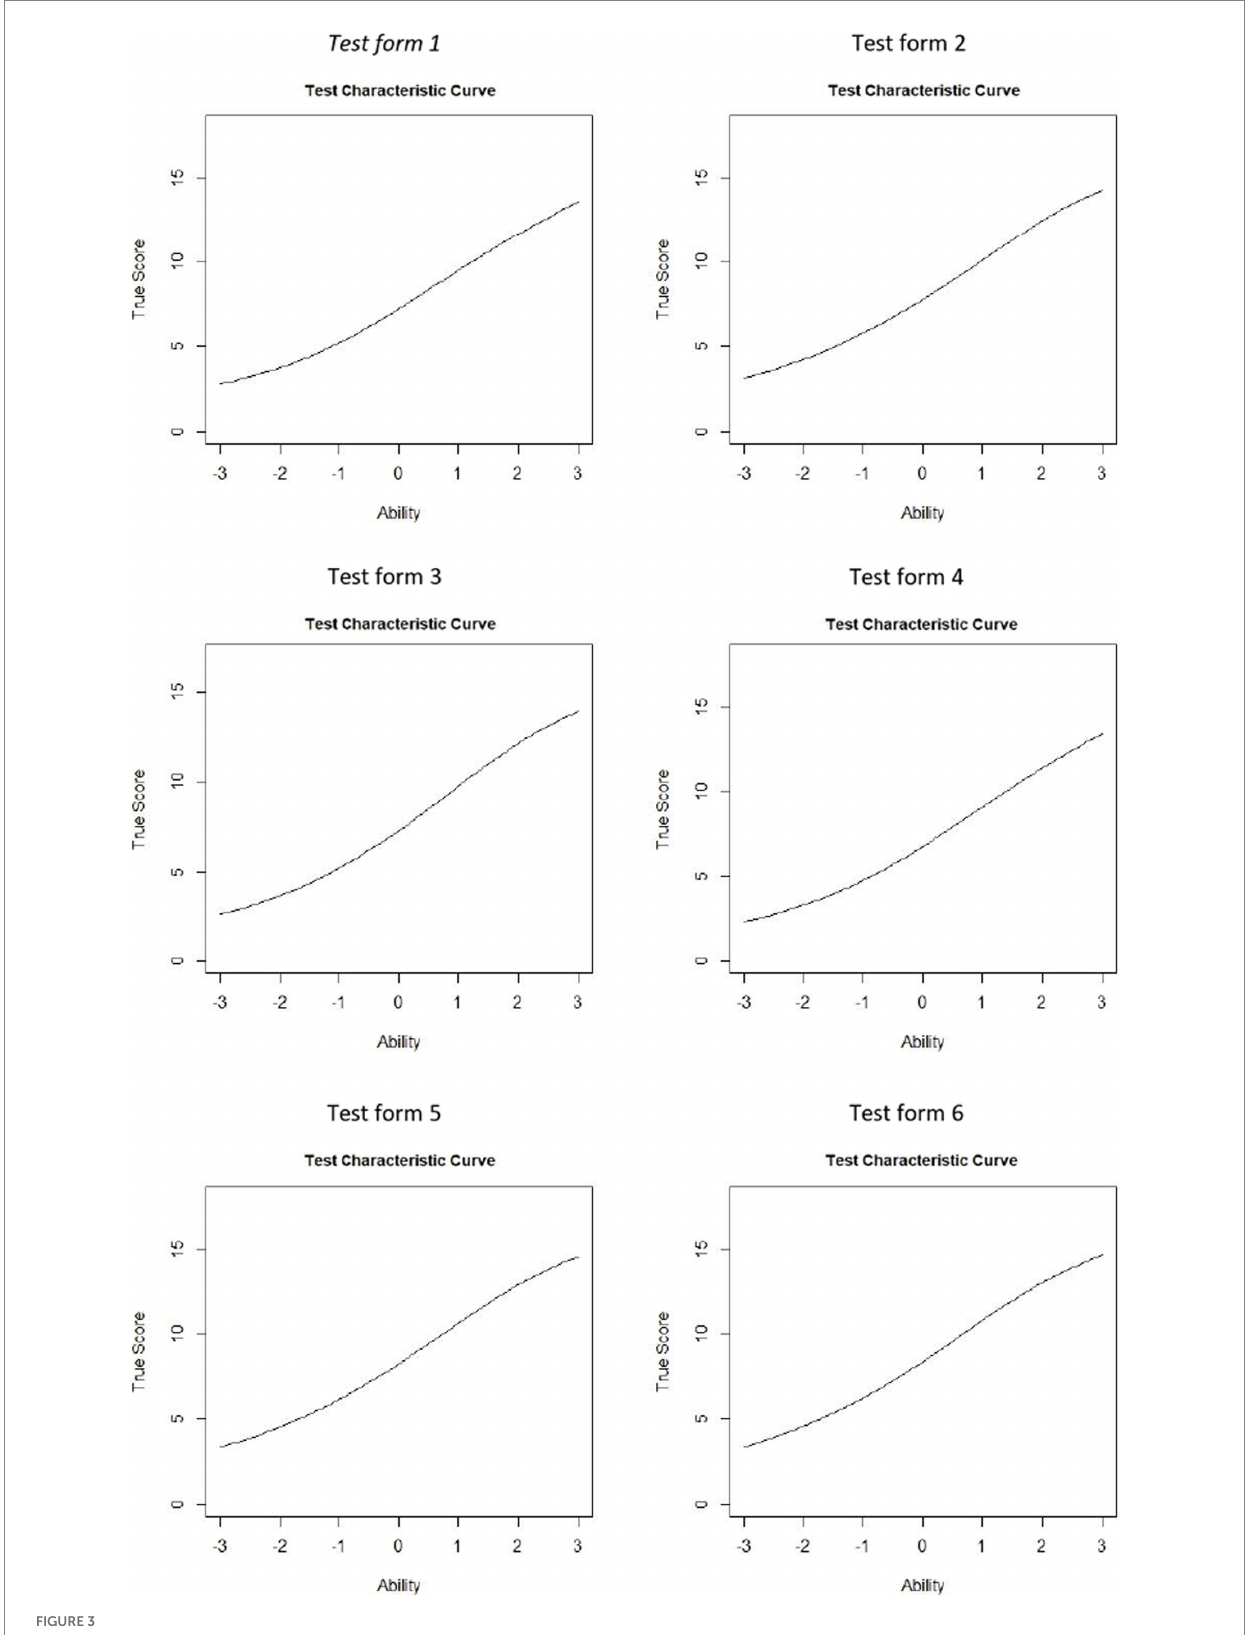
FIGURE 3 Test characteristic curve of six equivalent test